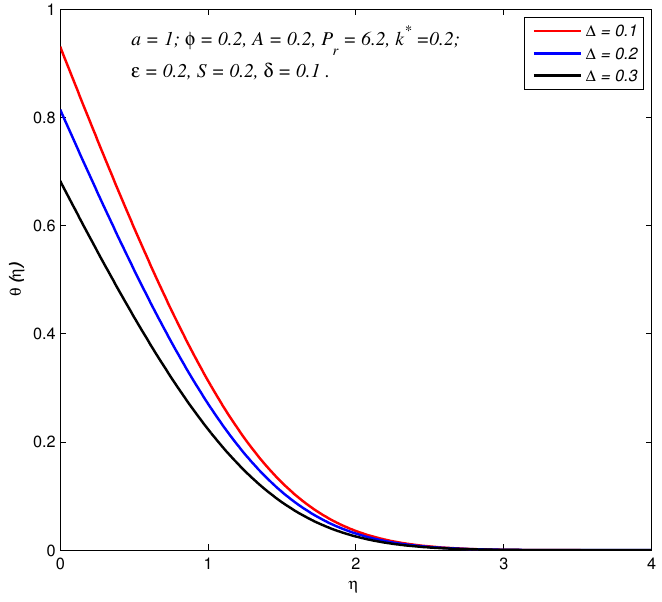
Figure 13. Temperature θ ( η ) profiles for different values of thermal slip parameter ∆ .